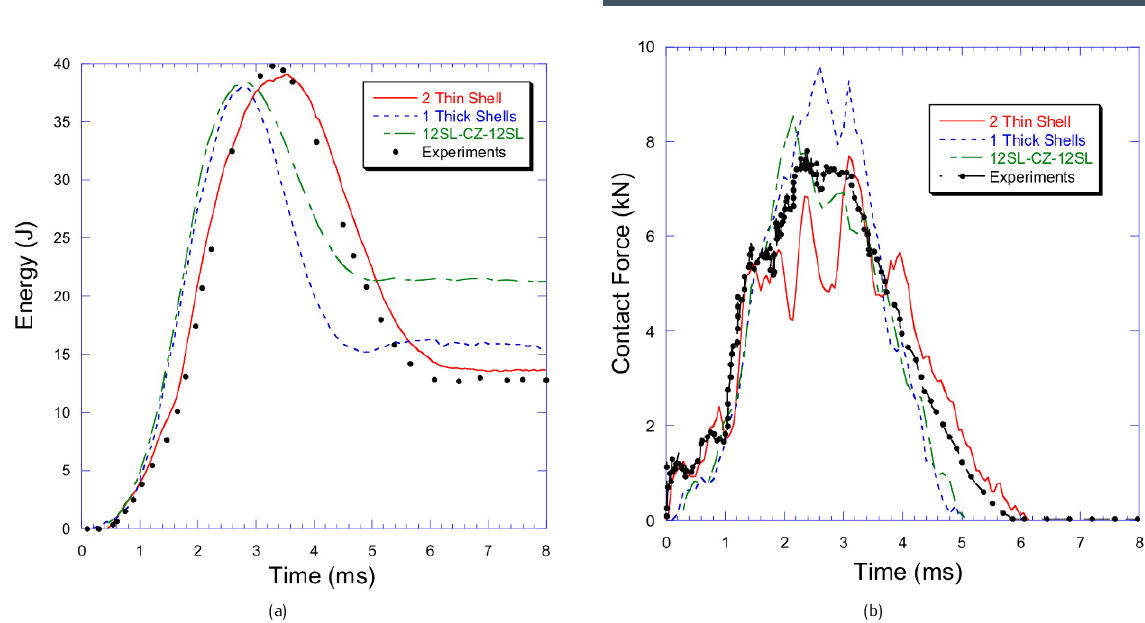
Figure 14. Comparison of internal energy and contact force of impacted plate from different modelling approaches. Experiment from [5].